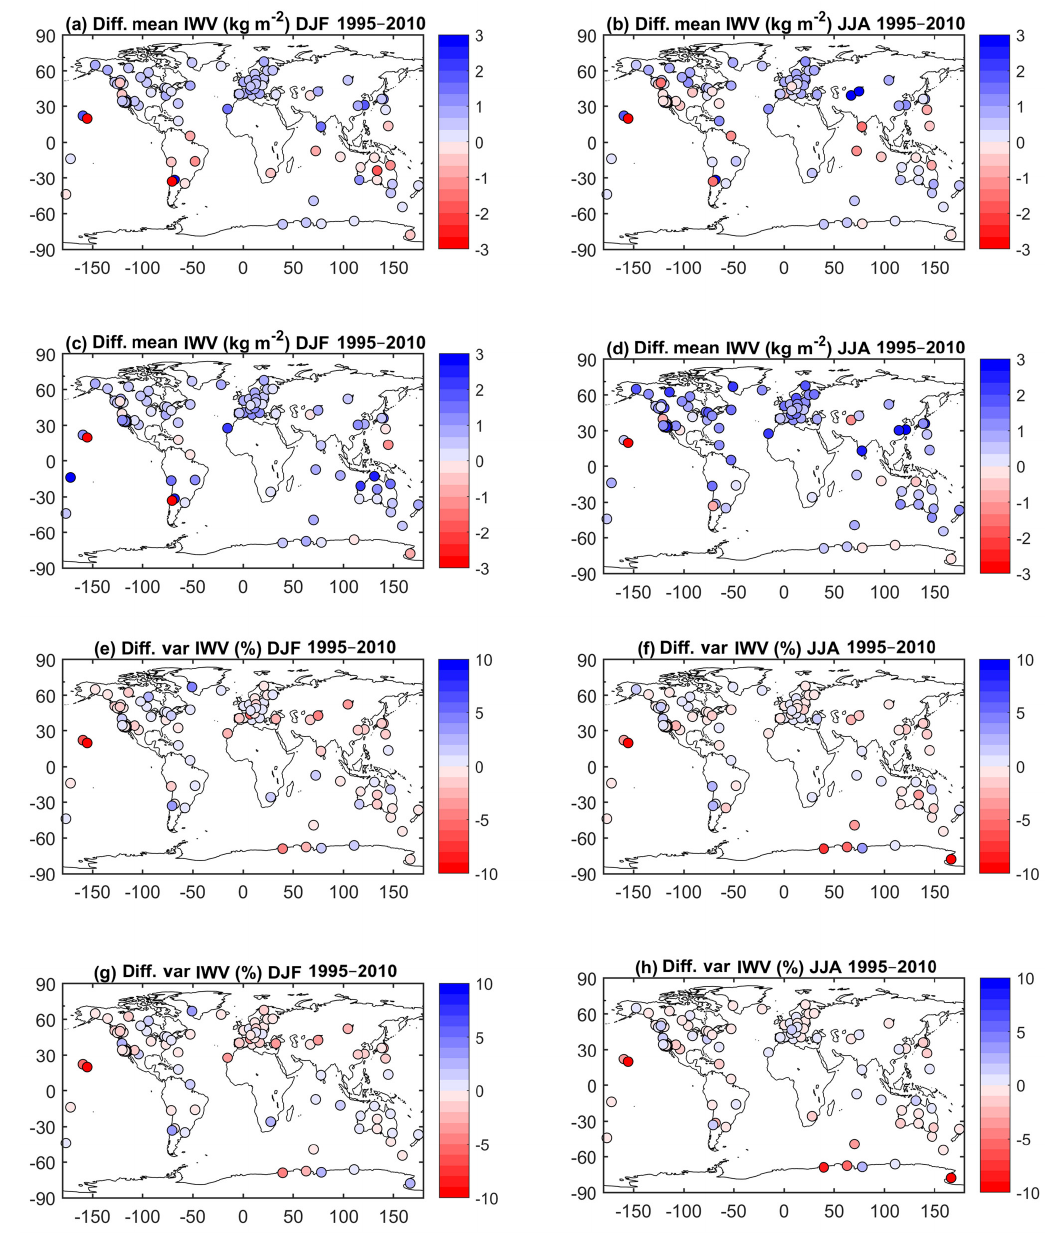
Figure 4. (a, b) Difference of mean IWV estimates (ERA-Interim minus GPS) for DJF and JJA 1995–2010; (c, d) same as panels (a) and (b) for MERRA-2 minus GPS. The monthly data were time-matched before seasonal means were computed. (e, f) Difference of relative standard deviations of IWV estimates (ERA-Interim SD minus GPS SD.) for DJF and JJA 1995–2010; (g, h) same as panels (e) and (f) for MERRA-2 minus GPS. The monthly data were time-matched before seasonal means were